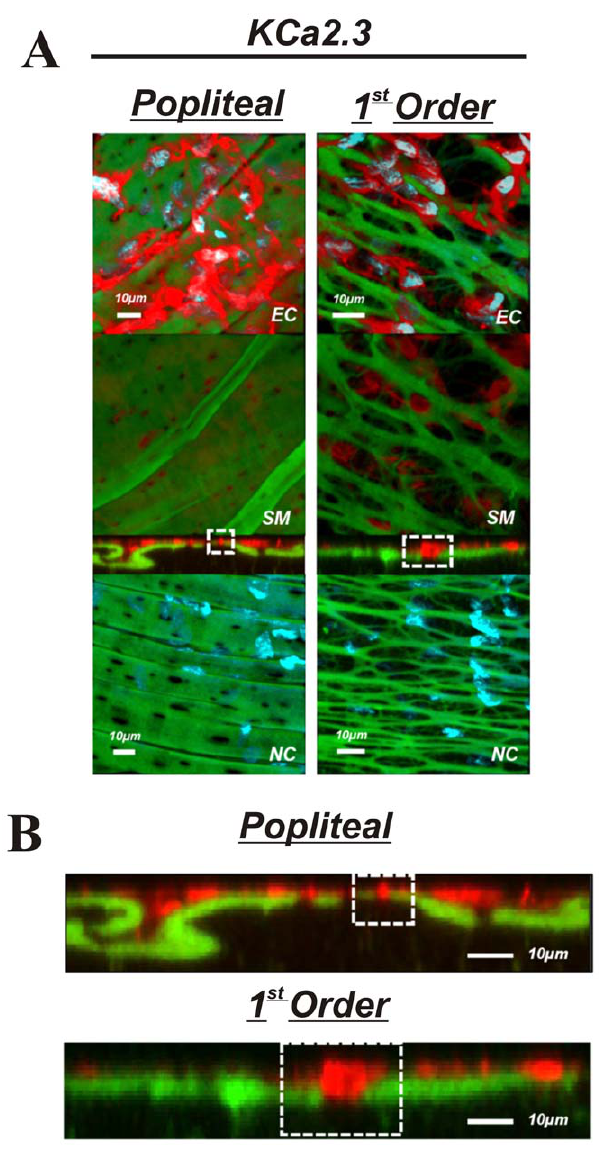
Figure 5. KCa2.3 in skeletal muscle arteries. A: Skeletal muscle popliteal (left) and 1 st order (right) arteries immunolabeled for KCa2.3 (top 3 panels) or no primary antibody control (bottom panel). The top image represents a composite of DAPI-stained nuclei in the endothe- lium, autofluorescence of the internal elastic lamina (green), and KCa2.3 immunolabeling (red), and a compressed z-stack image endothelial cell surface (EC, top panel). The second image is a compressed z-stack image from the perspective of the smooth muscle face (SM), the third image is a cross-sectional slice, and the fourth is a compressed z-stack image of a no primary antibody control (NC). Red staining indicates endothelial expression of KCa2.3. B: Magnified image of the cross- sectional view of the IEL. Note the sections highlighted by dotted square boxes indicating larger MEC and area of KCa2.3 staining in 1 st order arterioles. Bar=10 m m. Representative of images from tissue isolated from at least 3 animals.